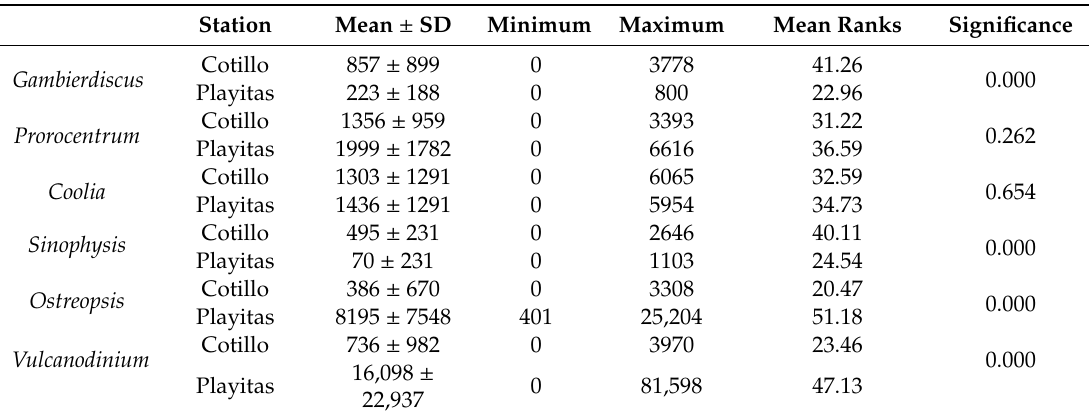
Table2. Statisticalvalues(mean, standarddeviation, minimum, maximum, meanranksandsignificance) of the abundances (cells gr − 1 wet weight) of dinoflagellate genera in Fuerteventura. Station Mean ± SD Minimum Maximum Mean Ranks